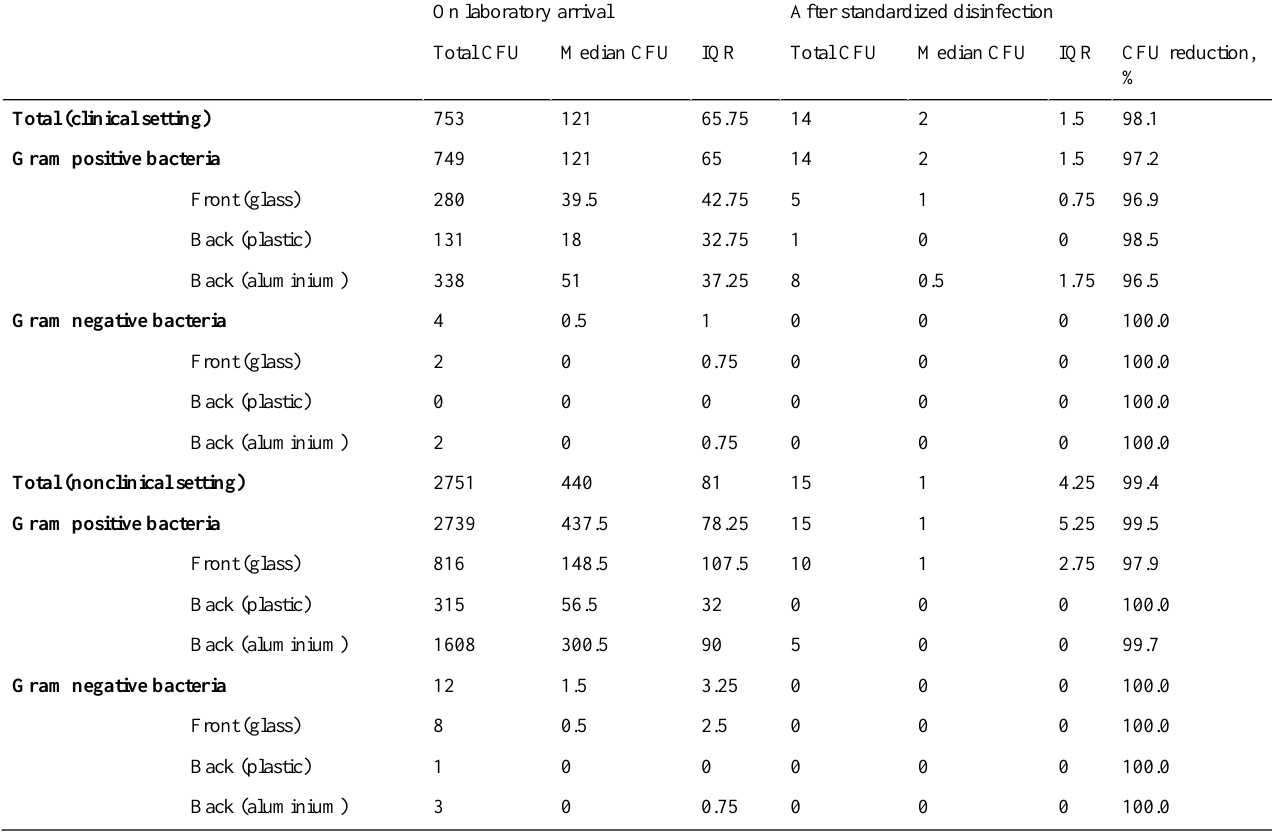
Table 3. Reduction of bacteria on the surface of 6 iPads after standard disinfection procedure stratified by the type of previous usage (clinical